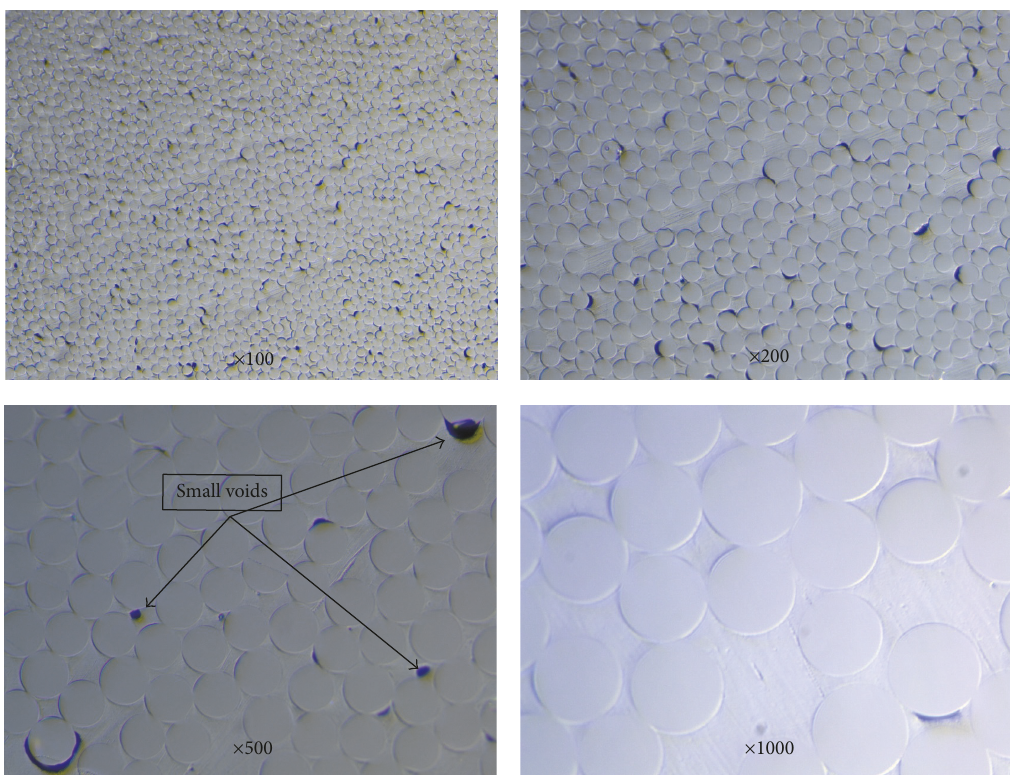
Figure 15: Optical microscopic images of Ref specimen.